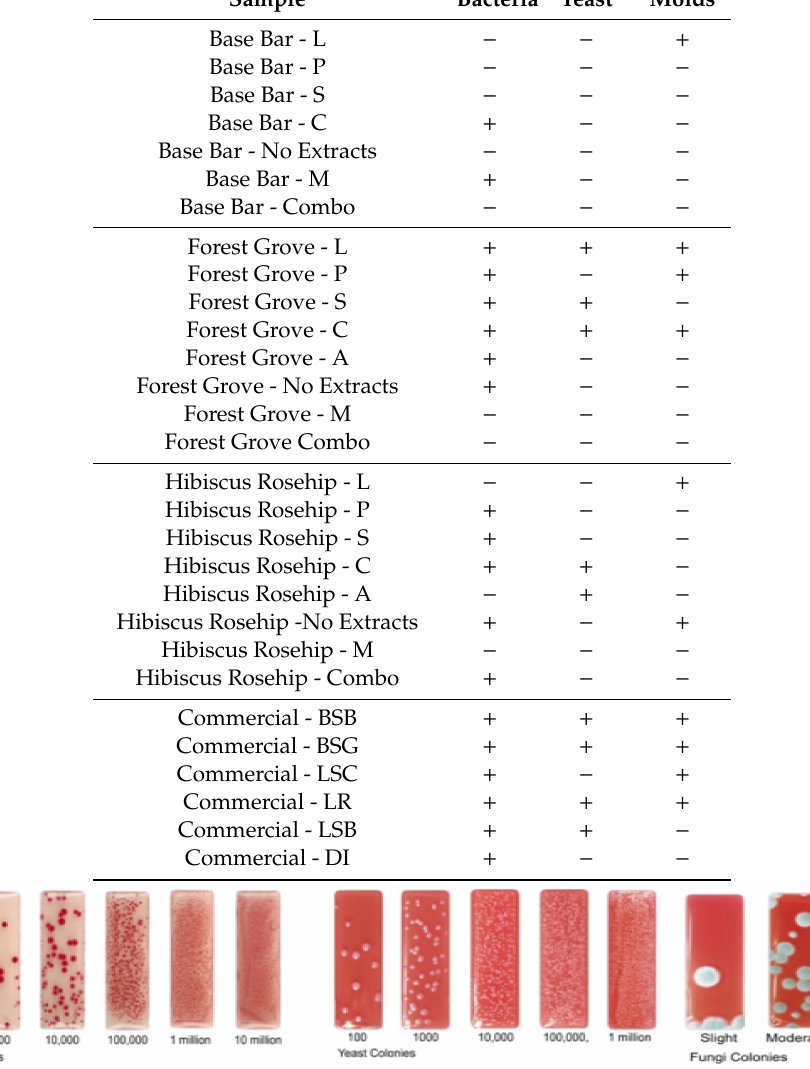
Table 1. Microbial growth in di ff erent natural and commercial soaps. ( + ) = indication of microbial growth, ( − ) = indication of microbial inhibition. Natural soap acronyms: BB = base bar, FG = forest grove, HR = hibiscus rosehip, A = essential old blend additives, L = blueberry, P = partridge berry, S = rosehip, C = cranberry, M = rosemary extracts, Combo = combination of berry extracts. Picture represents Lotioncrafter panel indicating colonies of bacteria, yeast, and fungi in the test